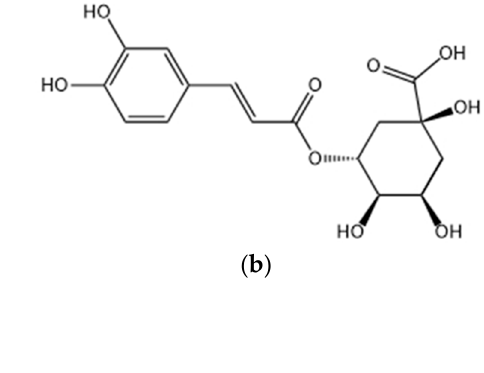
Figure 1. The basic structure of a coffee cherry.